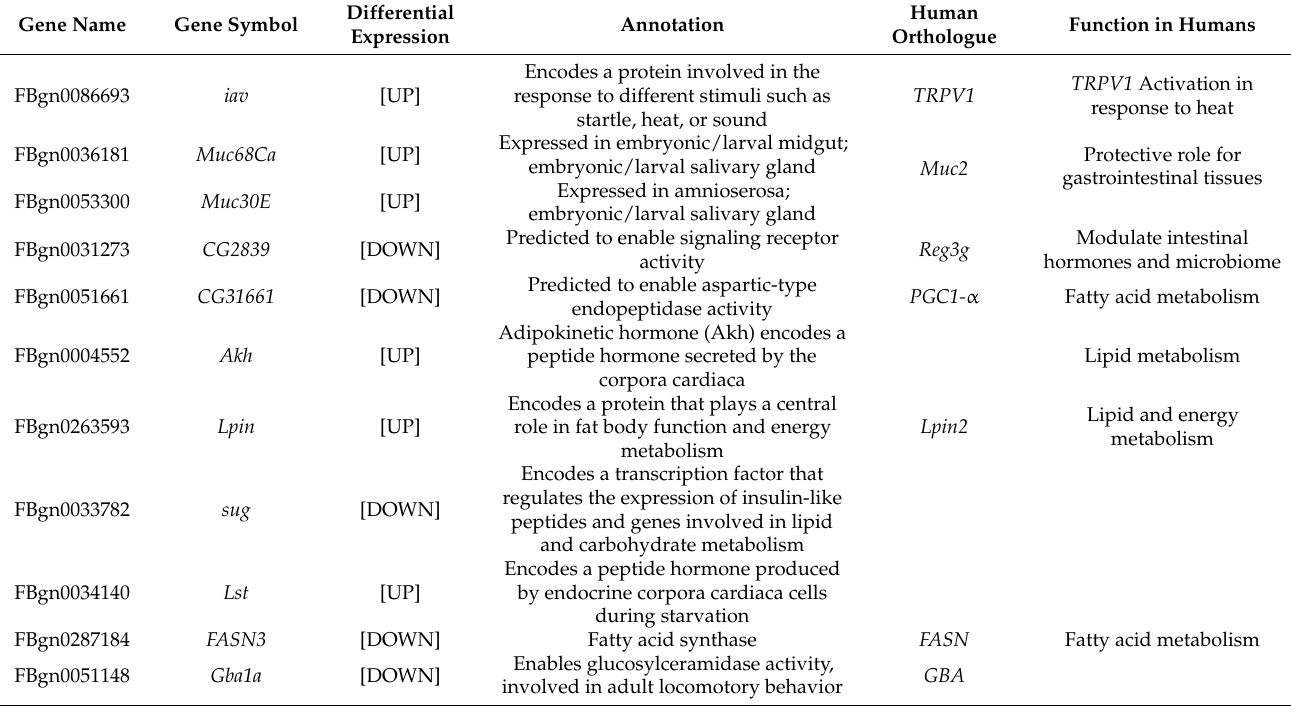
Table 1. Selected genes with differential expression in response to habanero-pepper diet and their orthologues in